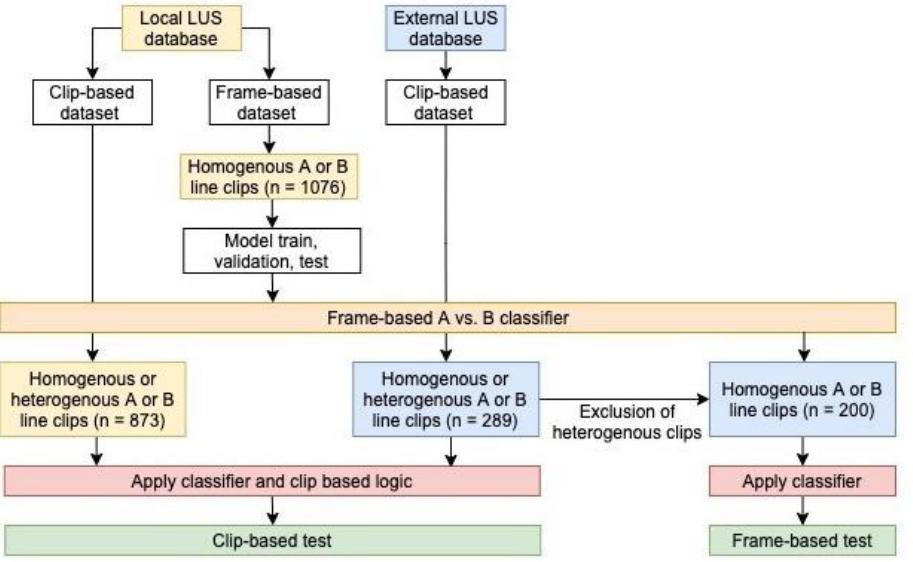
Figure 1. Flowchart of dataset creation, labelling, data allocation, and model training used in the study.